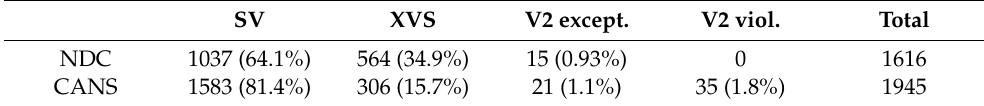
Table 1. Overview of the word order in AmSw declarative main clauses. SV XVS V2 except. V2 viol. Total NDC 1037 (64.1%) 564 (34.9%) CANS 1583 (81.4%) 306